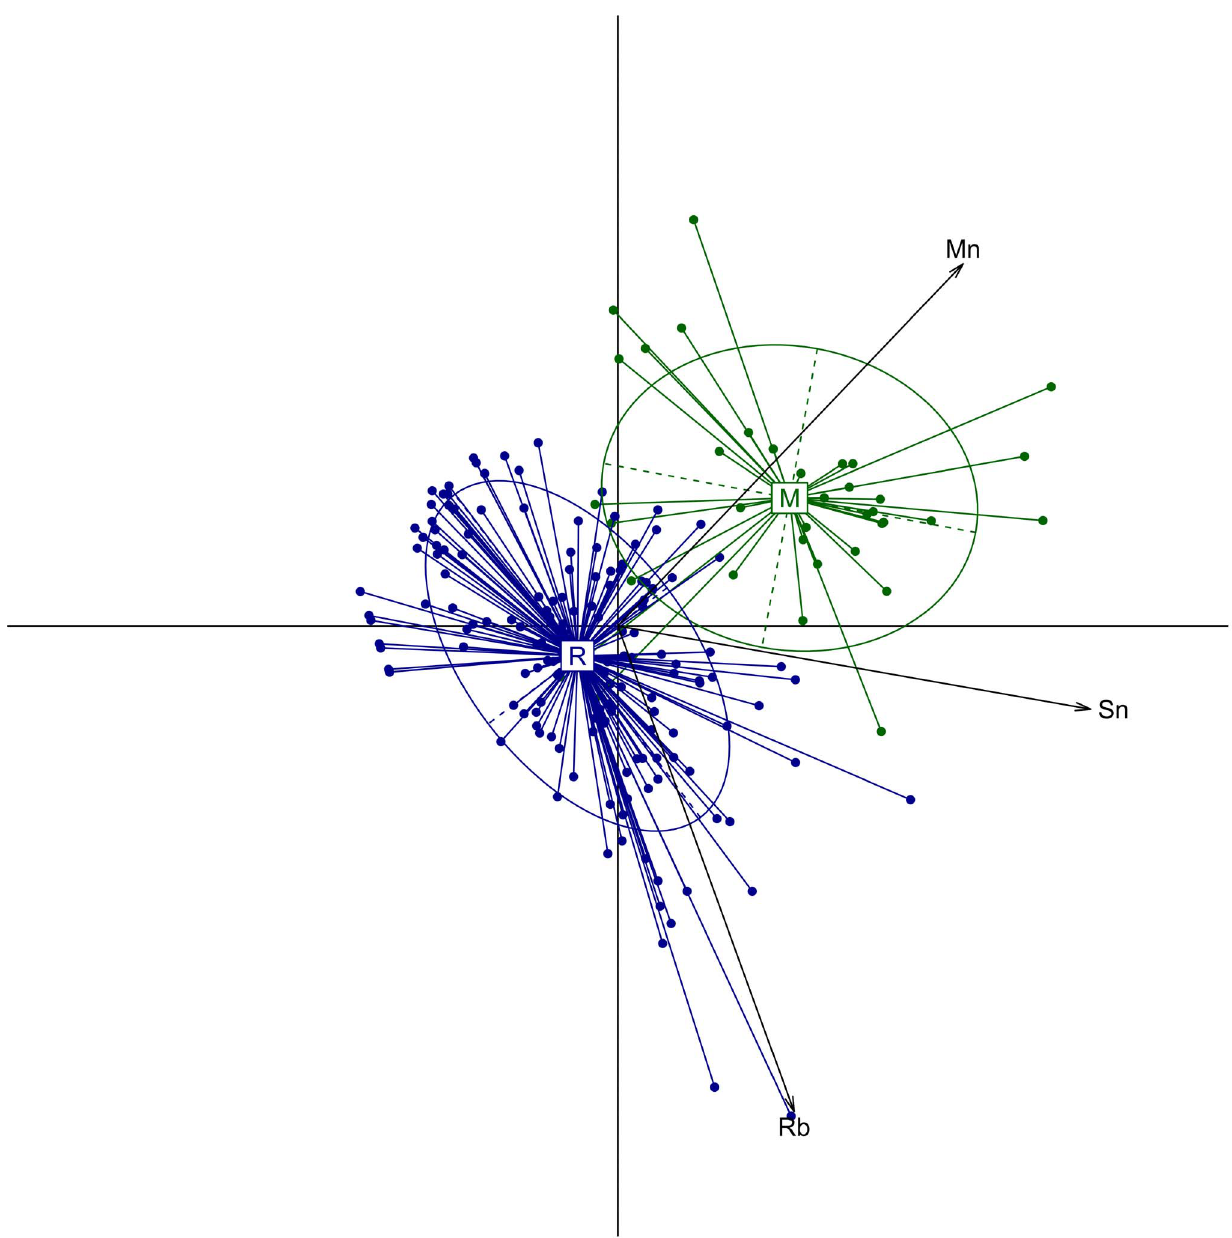
Figure 2. PCA biplot of otolith elemental concentrations from mangroves and reefs. Green and blue dots indicate the 37 fishes collected in mangroves (M) and the 159 fishes collected in reefs (R), respectively. Only concentrations of Rb, Sn and Mn in otoliths were used in the PCA.